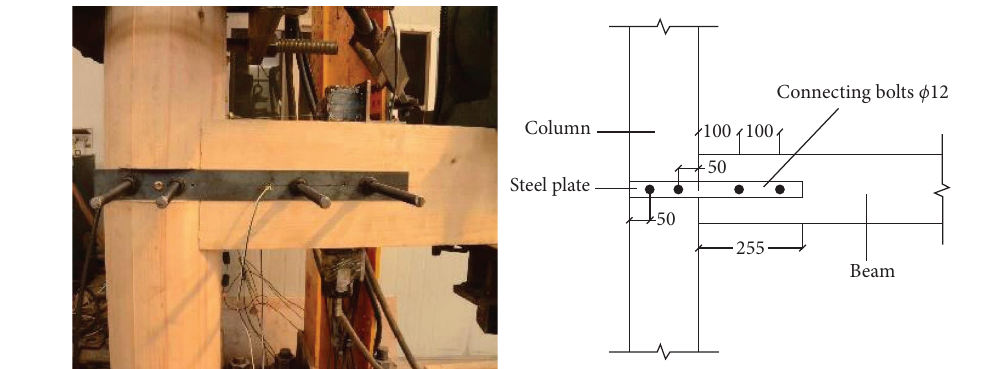
Figure 3: Diagram of specimens of reinforcement joints.